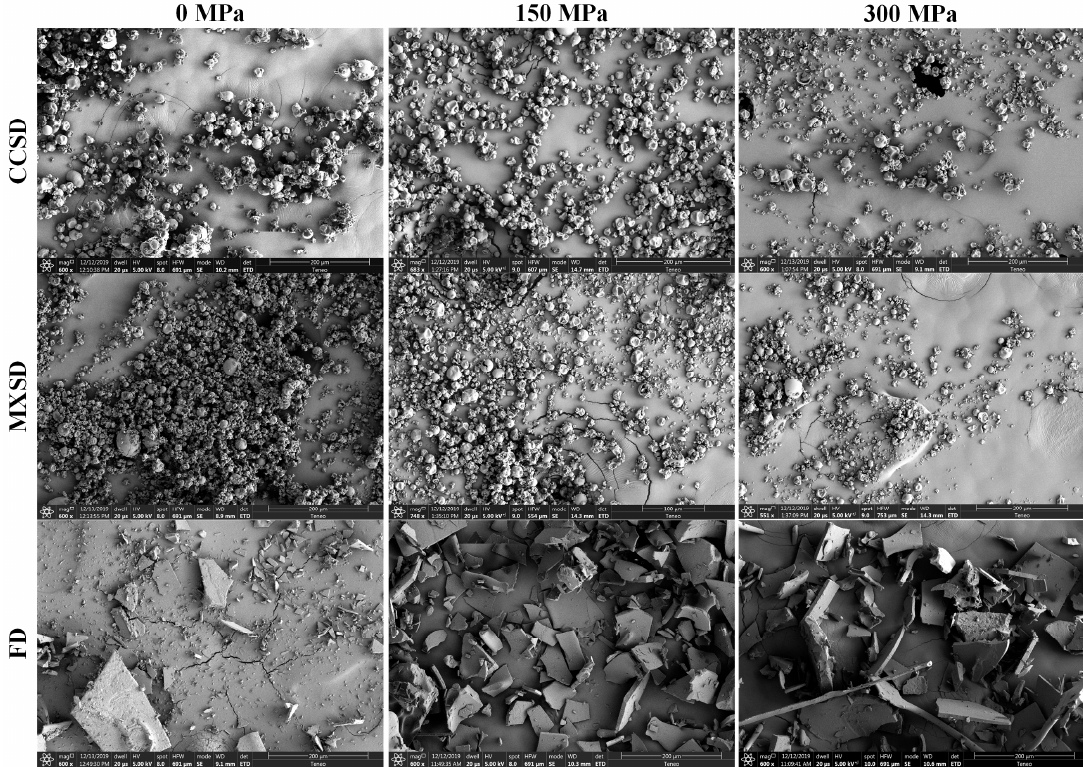
Figure 4. SEM micrographs of L. plantarum NRRL B-1927 powders microencapsulated with UHPH-treated skim milk via CCSD, MXSD and FD. Magnification is indicated on each micrograph, and varied from 550× to 750×.